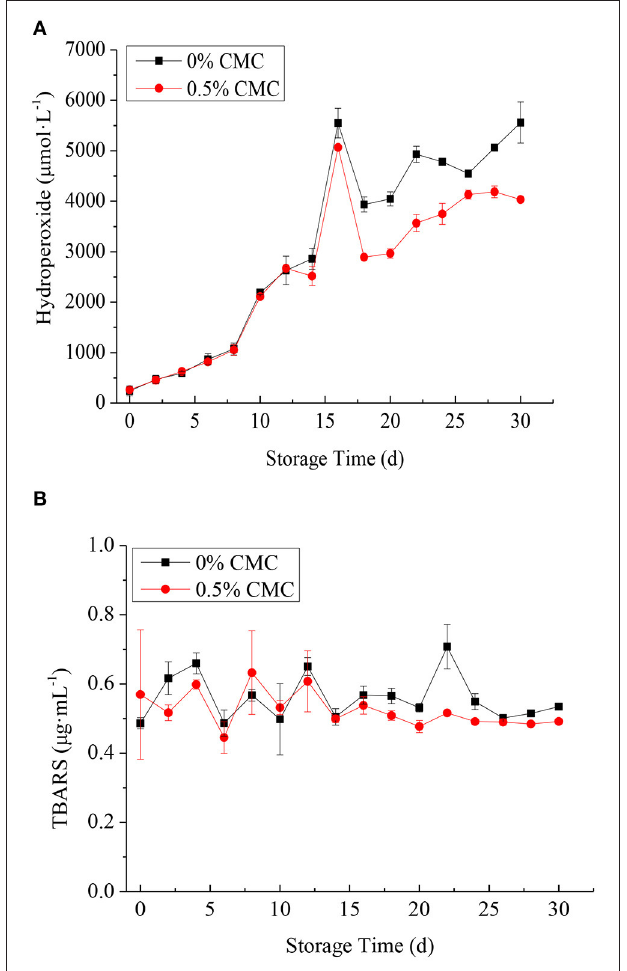
FIGURE 5 | The formation of lipid hydroperoxides ( µ mol/l emulsion) (A) and thiobarbituric acid reactive substances (TBARS) ( µ g/ml emulsion) (B) in SPI-stabilized rice bran oil emulsions with 0.5 wt% CMC during the incubation at 37 ◦ C. Data points represent means ( n = 3) ± SDs.